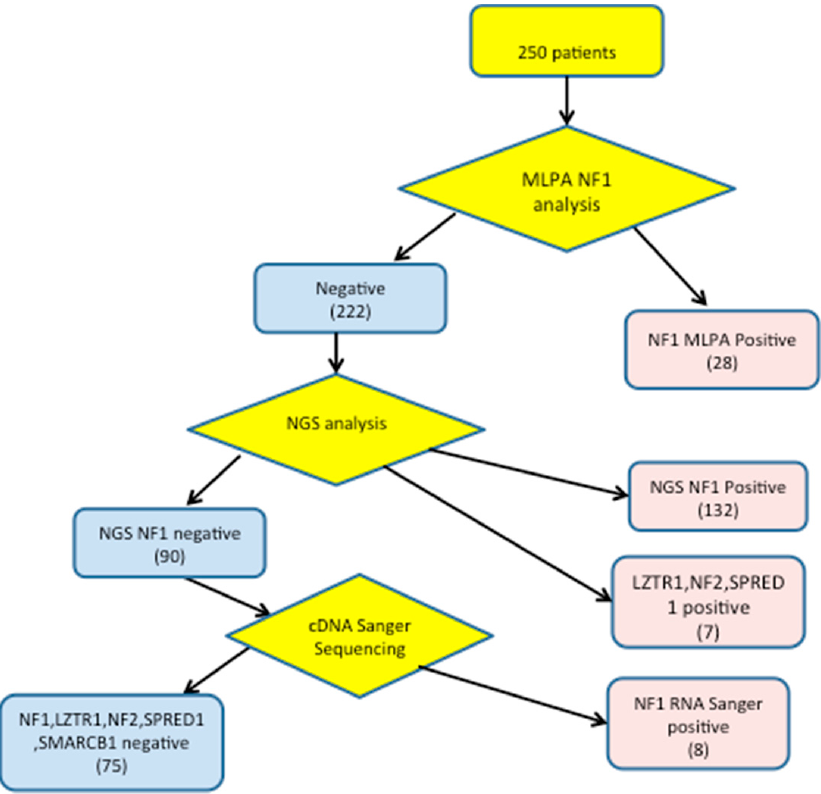
Figure 1. Molecular screening flow chart for patients with suspected NF1.